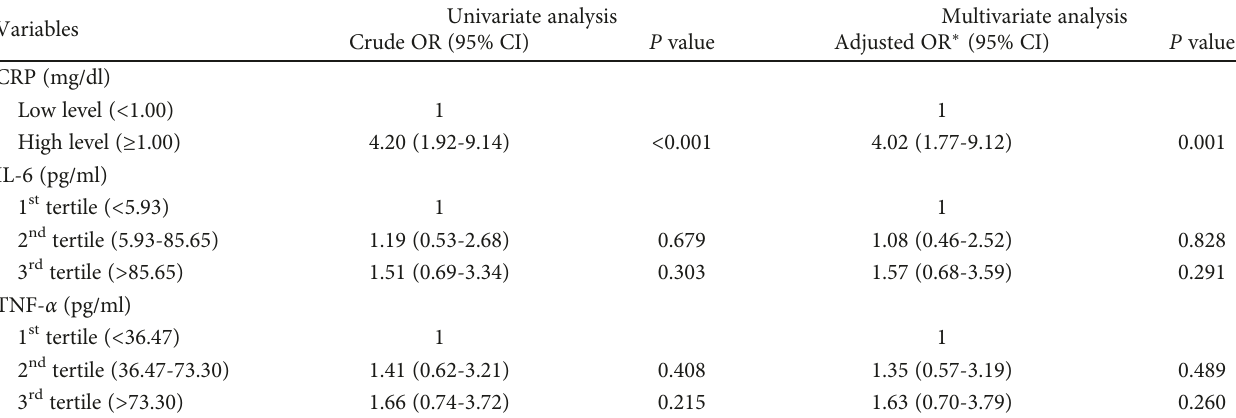
Table 3: Odds ratios (ORs) and 95% con fi dence intervals (CIs) for 2-year progression of type 2 diabetes according to baseline serum in fl ammatory marker